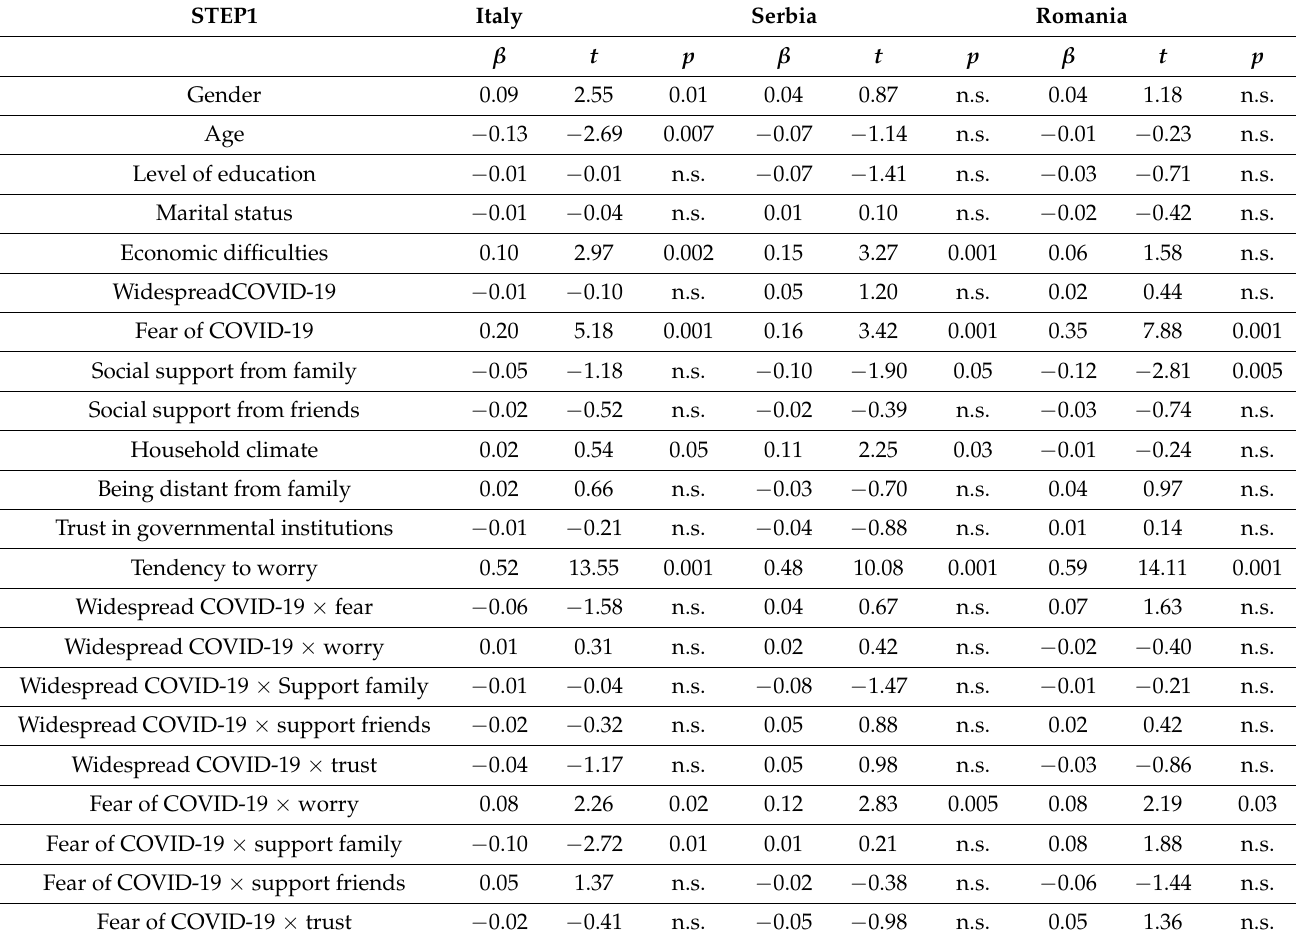
Table 4. Results of multiple regression